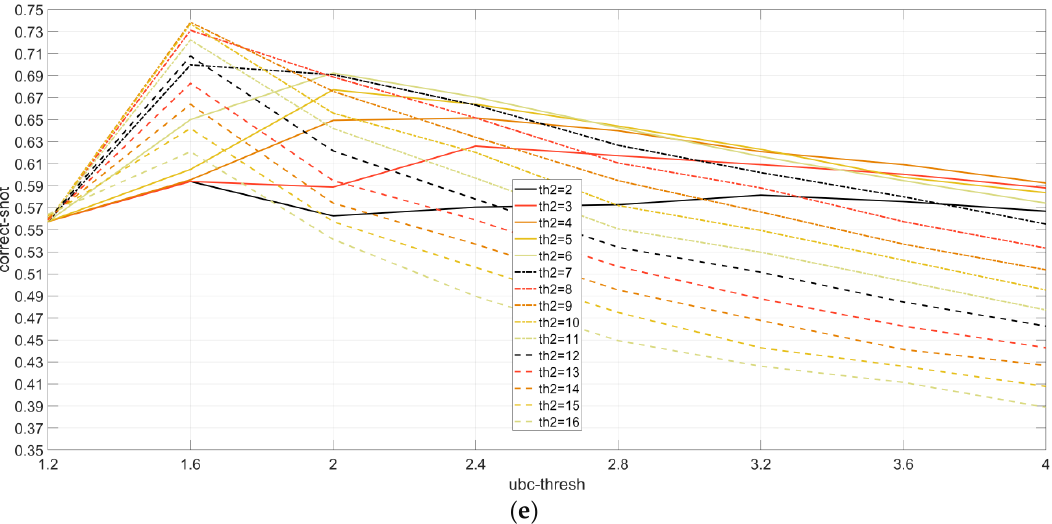
Figure 21. Examples of shot searching by using one image query under the transformations. ( a ) Transformation AT1; ( b ) Transformation AT2; ( c ) Transformation AT4; ( d ) Transformation AT7; ( e ) Transformation AT9.